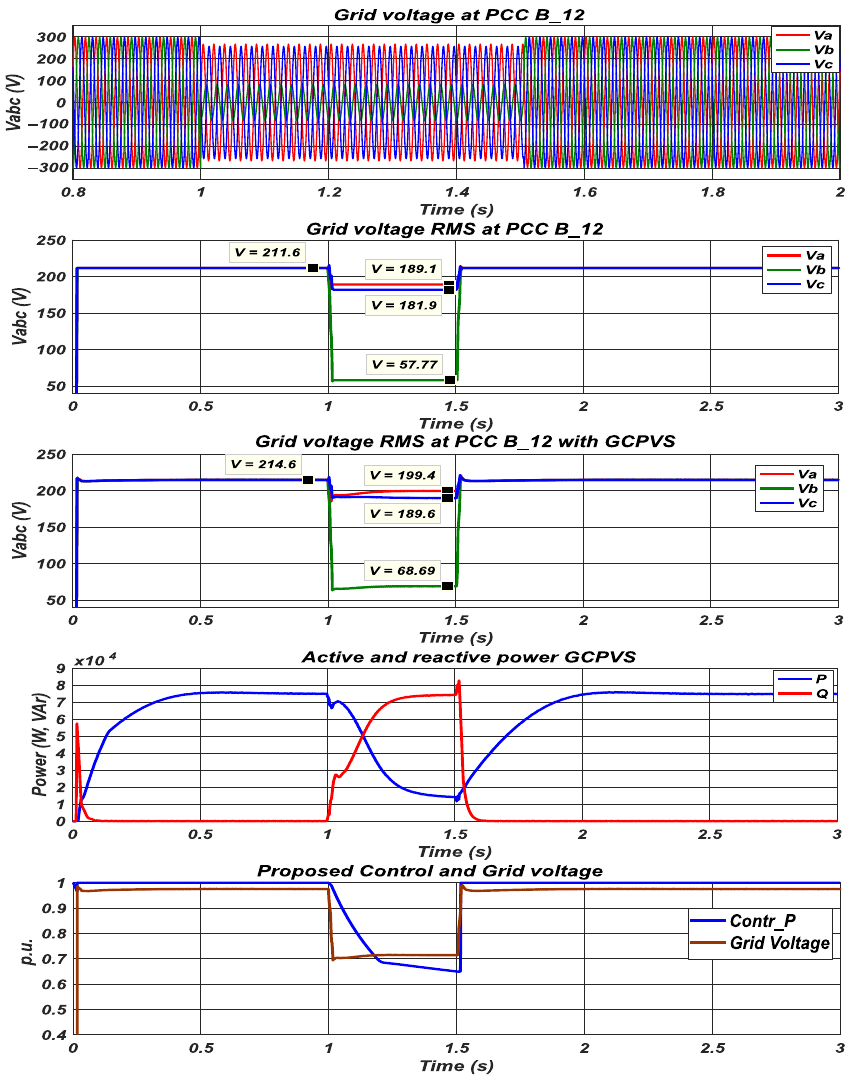
Figure 14 . Simulation results of the GCPVS proposed for SDVV/MVD: phase-to-phase short-circuit for 500 ms.